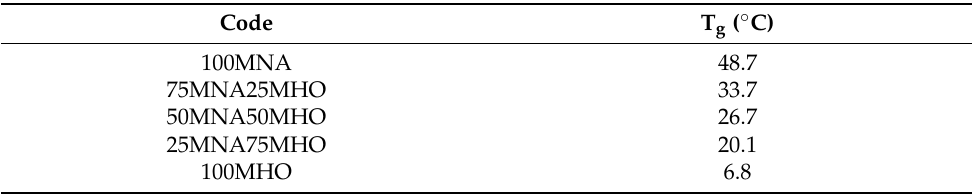
Figure 8. Phase angle variation for EHO-based resins crosslinked with a mixture of maleinized linseed oil (MHO) and methyl nadic anhydride (MNA). Table 5. Values of glass transition temperature (T g ) for EHO-based resins crosslinked with a mixture of maleinized linseed oil (MHO) and methyl nadic anhydride (MNA).